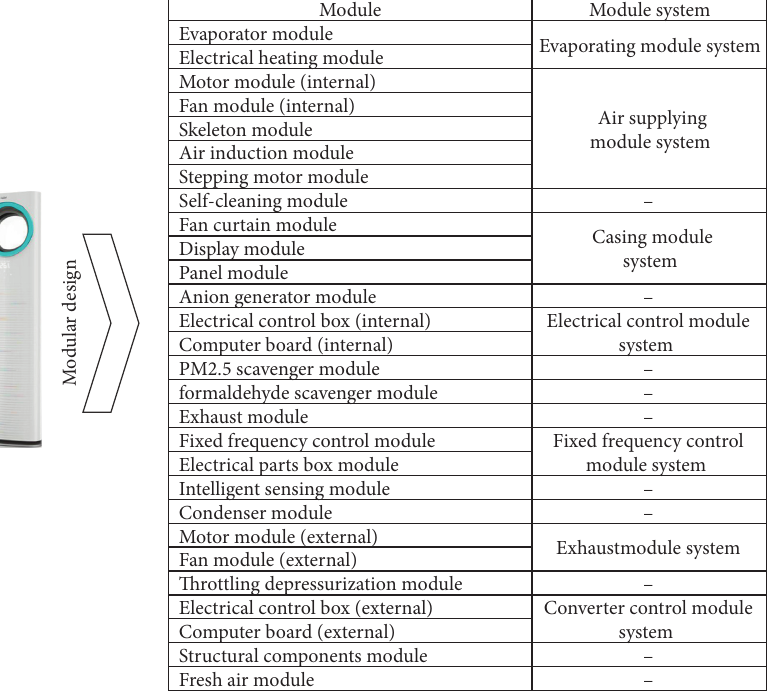
Figure 4: The modular product architecture of T-AC.